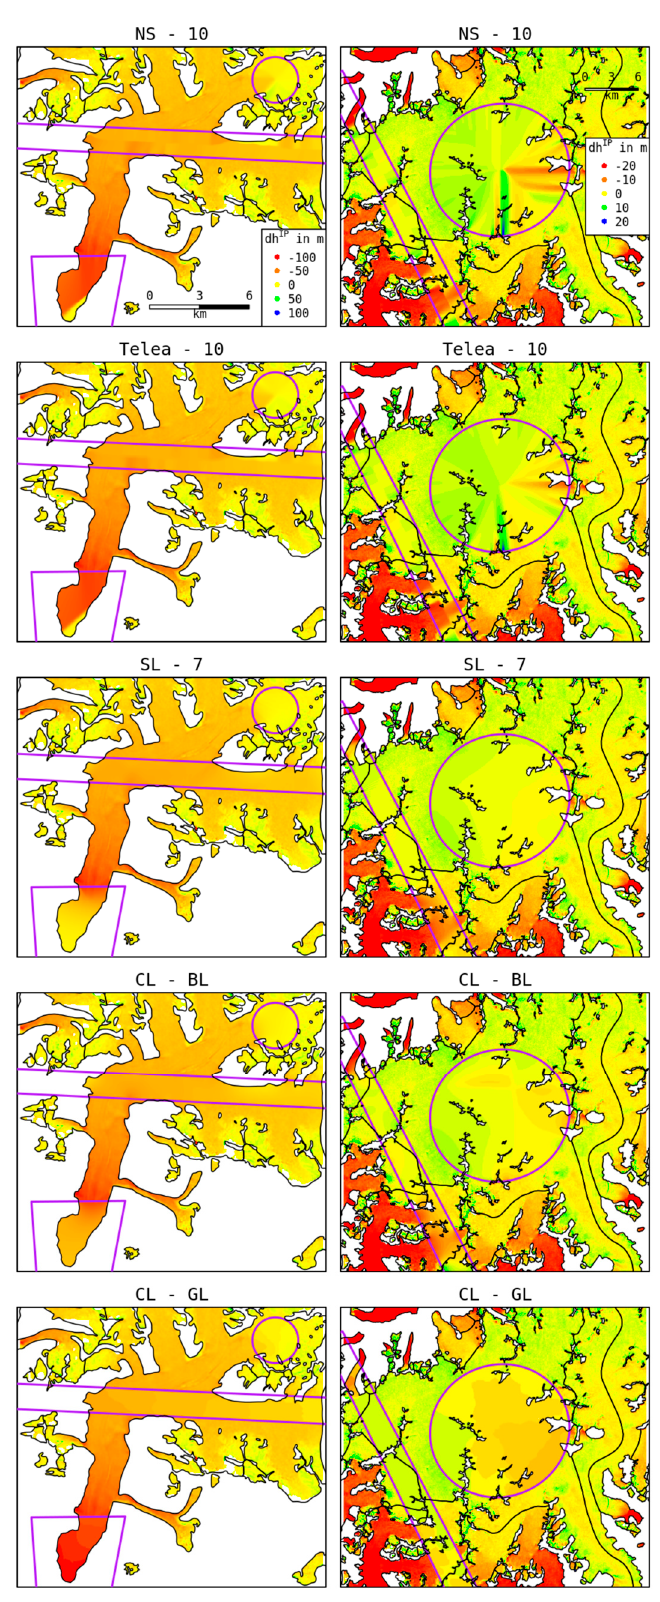
Figure 4. Void filling results of the different approaches (one per approach) at the Center (left column) and Juneau (right column) setups. See Figures S1 and S2 for more results.